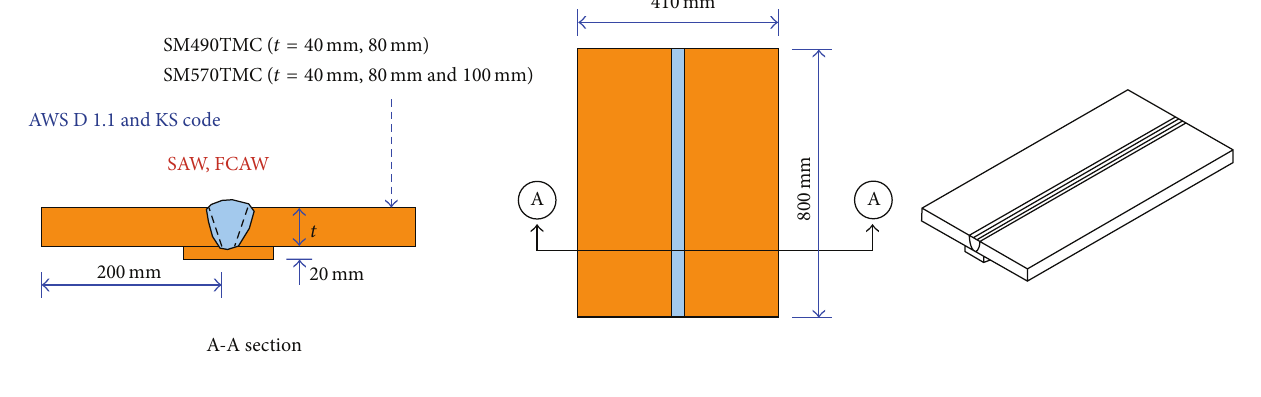
Figure 1: Welding test steel plate before being